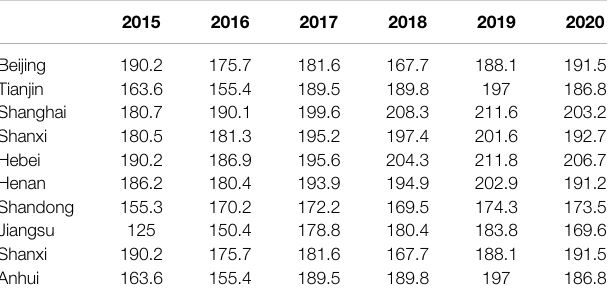
TABLE 2 | Annual average 90% quantile concentration of 8-h O 3 in seven provinces and three